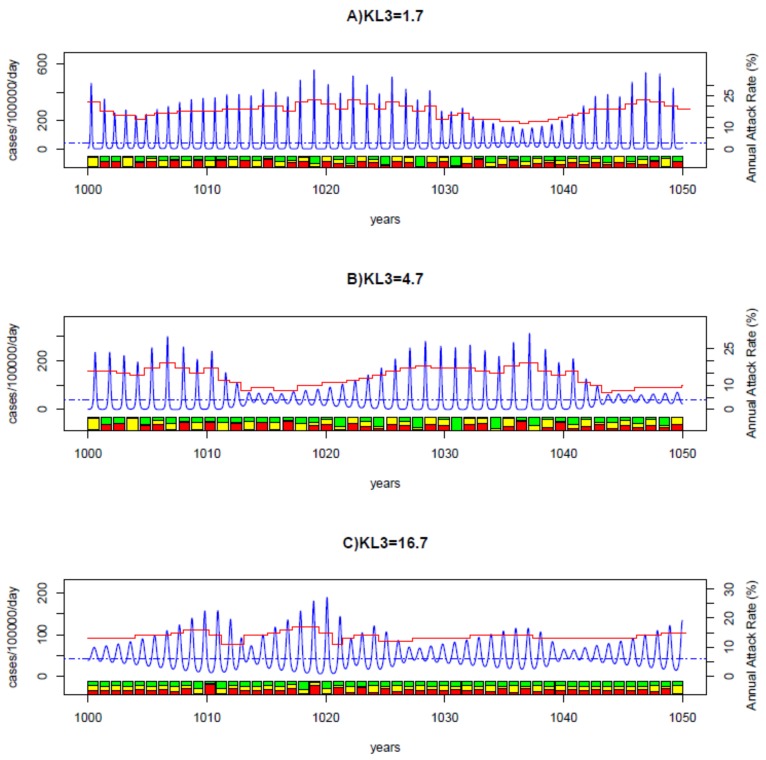
Examples of model output time series.The blue lines show the total case incidence, the red lines the annual attack rate and the bottom bar plot shows the fractions of the three strains (represented by three different colours). The dashed blue straight line represents the threshold level of 42 cases per 100000 person-days for defining an epidemic. Other parameters are as baseline values in Table 2. Model parameters: A) R
0 = 2.5, D = 4.5 years, ψ = 0.75, ϕ = 2.3. The infection time series generated has a mean IEP of 1.0 year, a mean DE of 14 weeks and a mean AR of 18%, with its overall goodness of fit: KL3 = 1.7 (KL_DE = 1.1, KL_IEP = 0.2, KL_AR = 0.4). B) R
0 = 2.0, D = 5.0 years, ψ = 0.70, ϕ = 2.5. The infection time series generated has a mean IEP of 1.1 years, a mean DE of 19 weeks and a mean AR of 13%, with its KL3 = 4.7 (KL_DE = 3.1, KL_IEP = 0.7, KL_AR = 0.2); C) R
0 = 2.0, D = 5.0 years, ψ = 0.50, ϕ = 2.5. The infection time series generated has a mean IEP of 1.0 year, a mean DE of 27 weeks and a mean AR of 13%, with its KL3 = 16.7 (KL_DE = 14.7, KL_IEP = 0.7, KL_AR = 1.2).